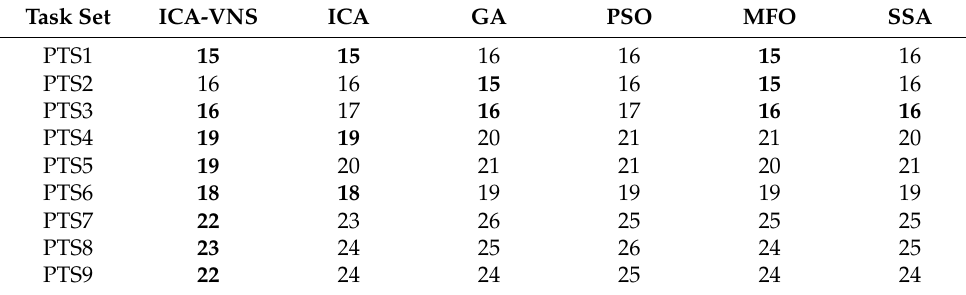
Table 8. The Best value comparison of sixalgorithms.